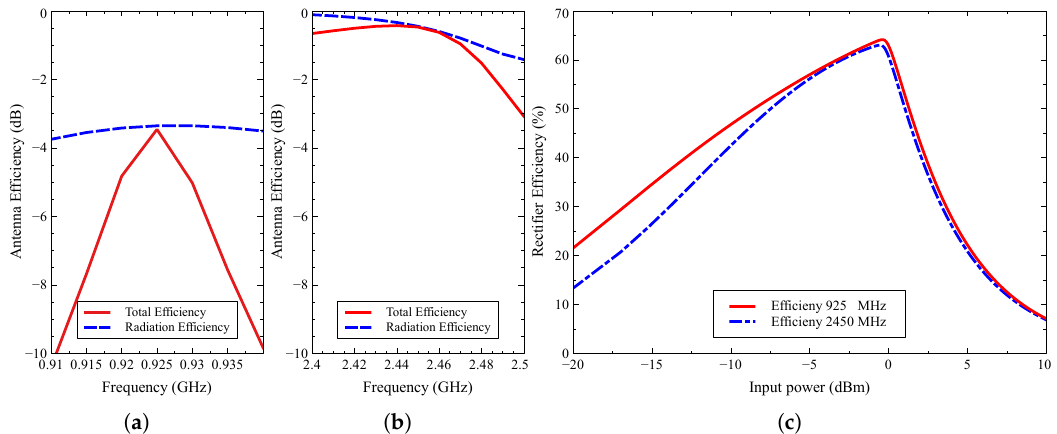
Figure 9. Simulated results of rectenna. The antenna efficiency of ( a ) at low-frequency band and ( b ) at high-frequency band. ( c ) The efficiency of rectifier circuit.